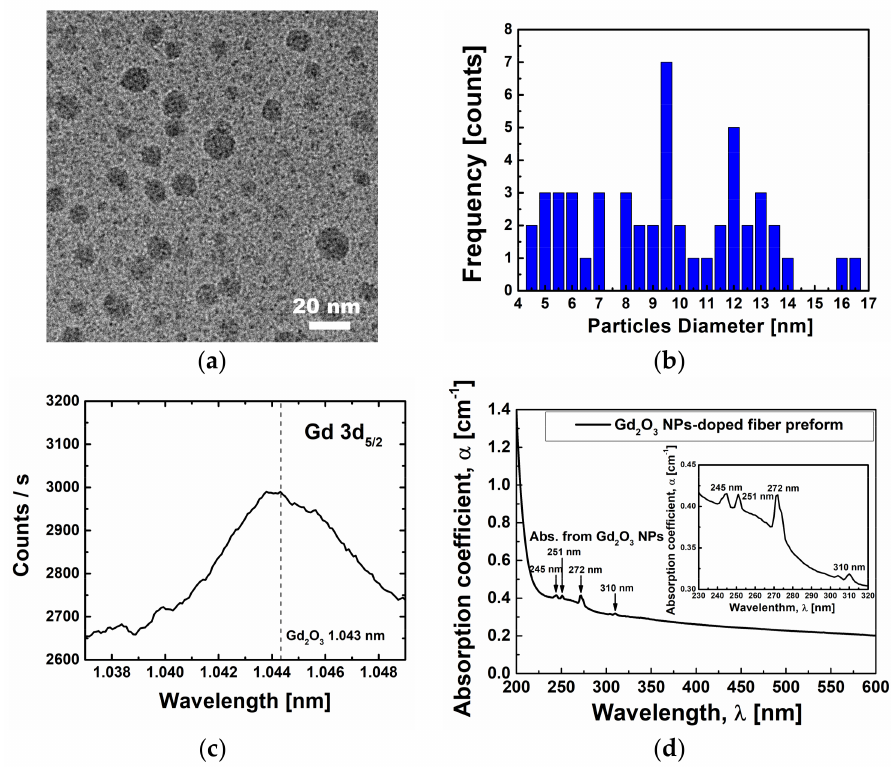
Figure 3. ( a ) TEM image; ( b ) size distribution; ( c ) XPS spectrum; and ( d ) UV-VIS spectrum of the Gd 2 O 3 NPs-doped fiber